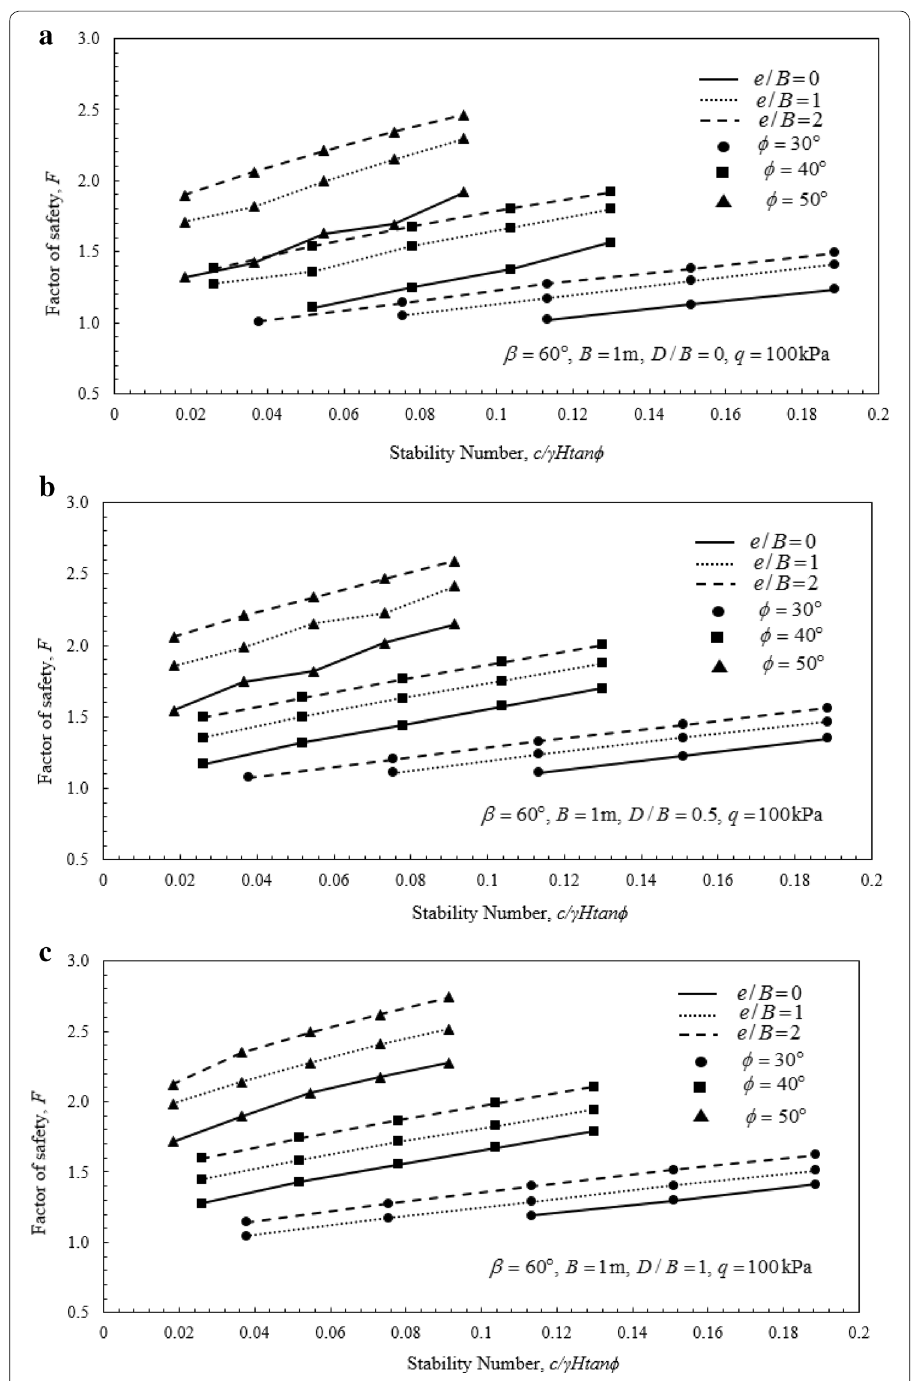
Fig. 16 Design Charts for β = 60 ◦ : a D / B = 0 , b D / B = 0.5 , c D / B =